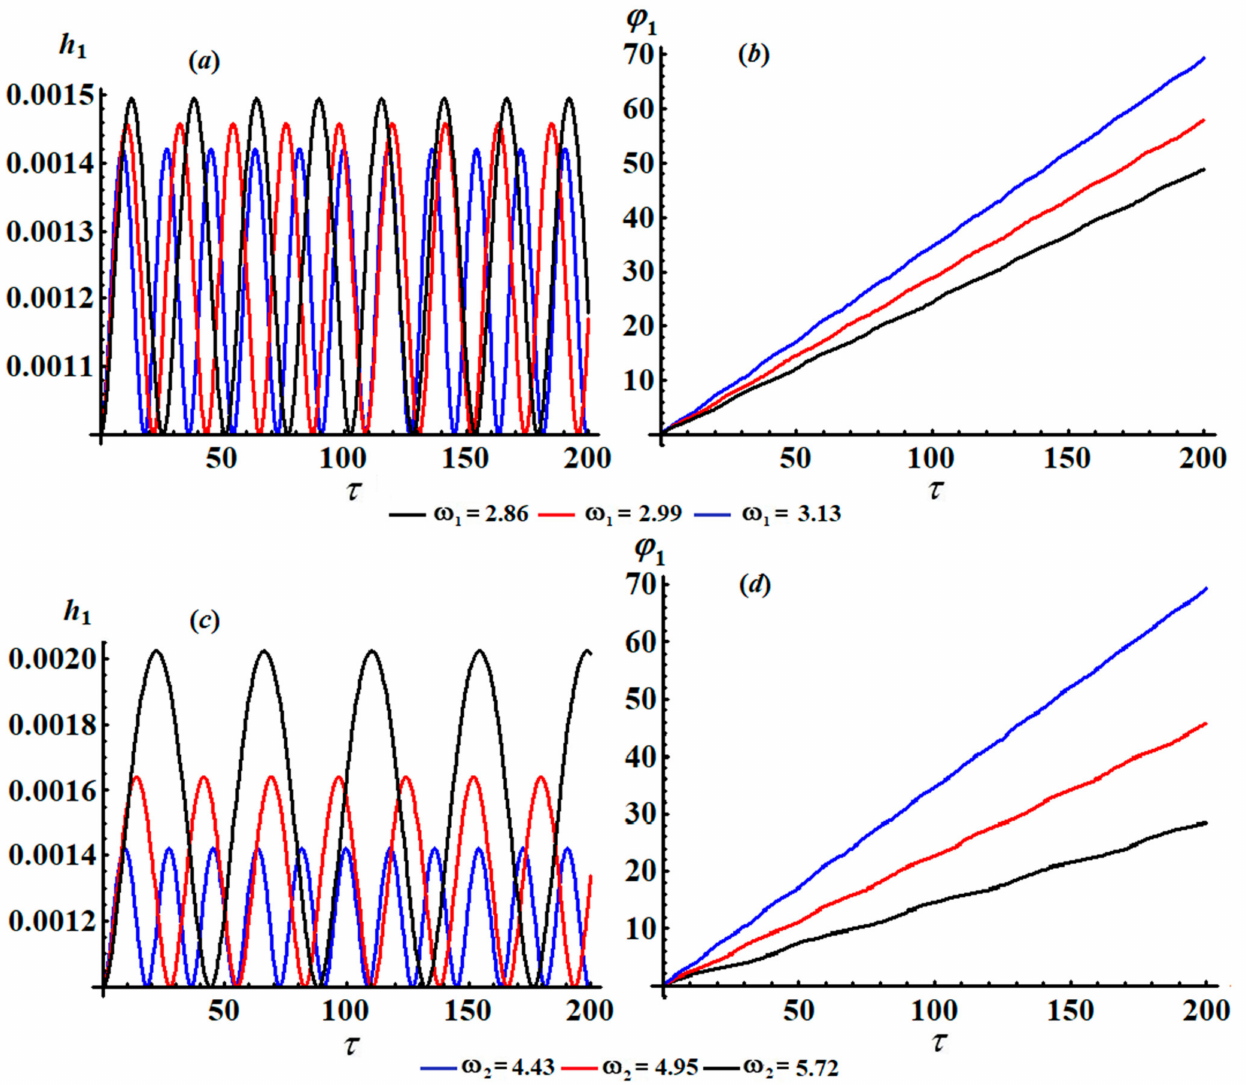
Figure 2. Demonstration of the modulation of the amplitude h 1 and modified phase ϕ 1 : ( a,b ) at ω 1 = ( 2.86,2.99,3.13 ) , ( c,d ) at ω 2 = ( 4.43,4.95,5.72 )